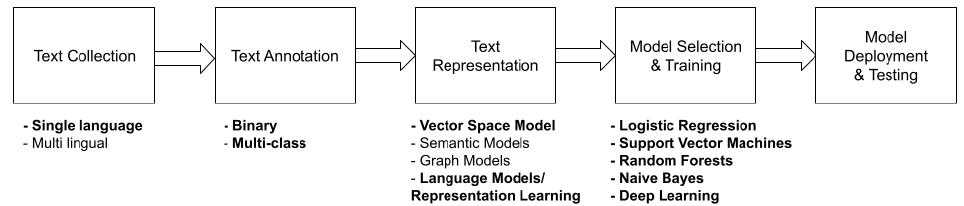
Figure 2. The basic steps for text classification and the proposed